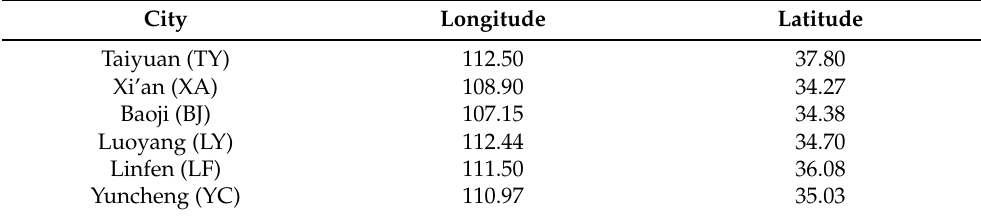
Figure 1. The computational area and the nested domains used in the model. Stations possessing observed data were also marked by black points. Table 1. Locations of cities in Fenwei